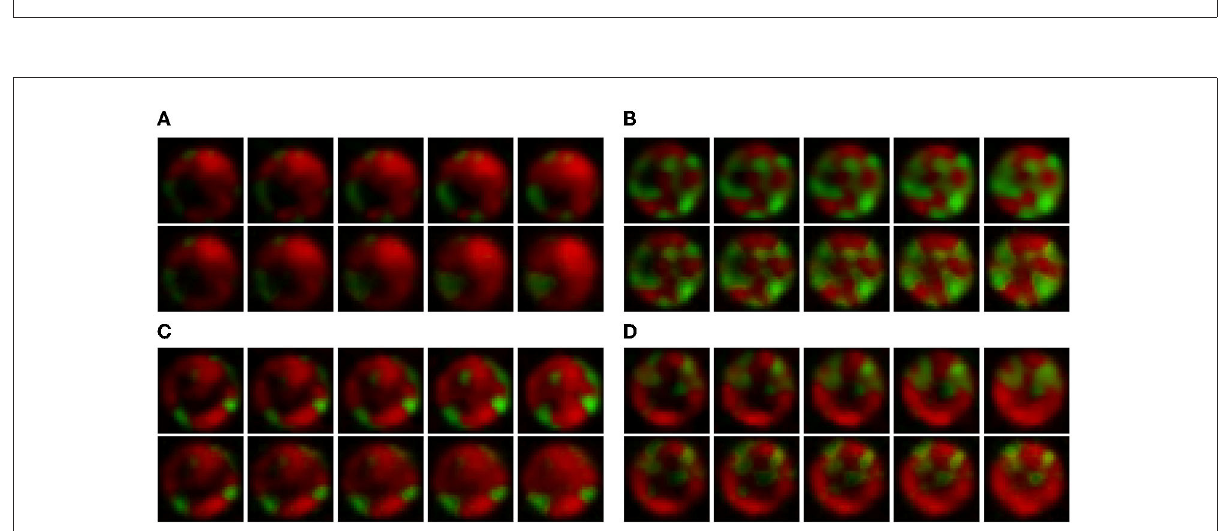
FIGURE4 Qualitative comparison between the groundtruth and predicted frames for four wells in the test dataset. In each figure, the upper panel represents the groundtruth frames, and the lower the predicted frames. The images progress from left to right and the wells are numbered according to their position in the test dataset. Data taken from Timm et al. (2017) then expanded in size and interpolated in time as explained in Section 2.